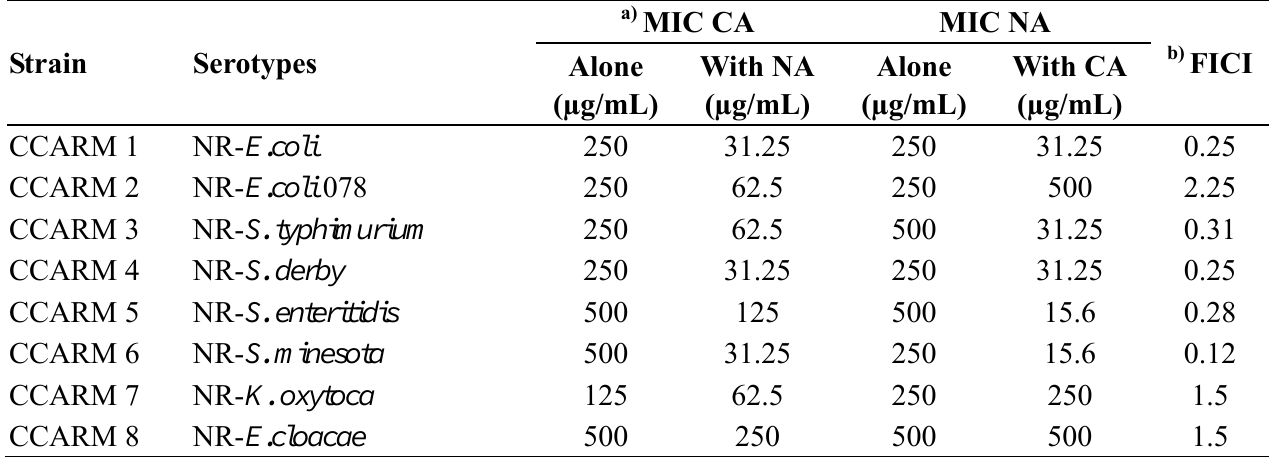
Table 2. Result of the combined effect of carvacrol (CA) and nalidixic acid (NA) against nalidixic acid-resistant pathogenic